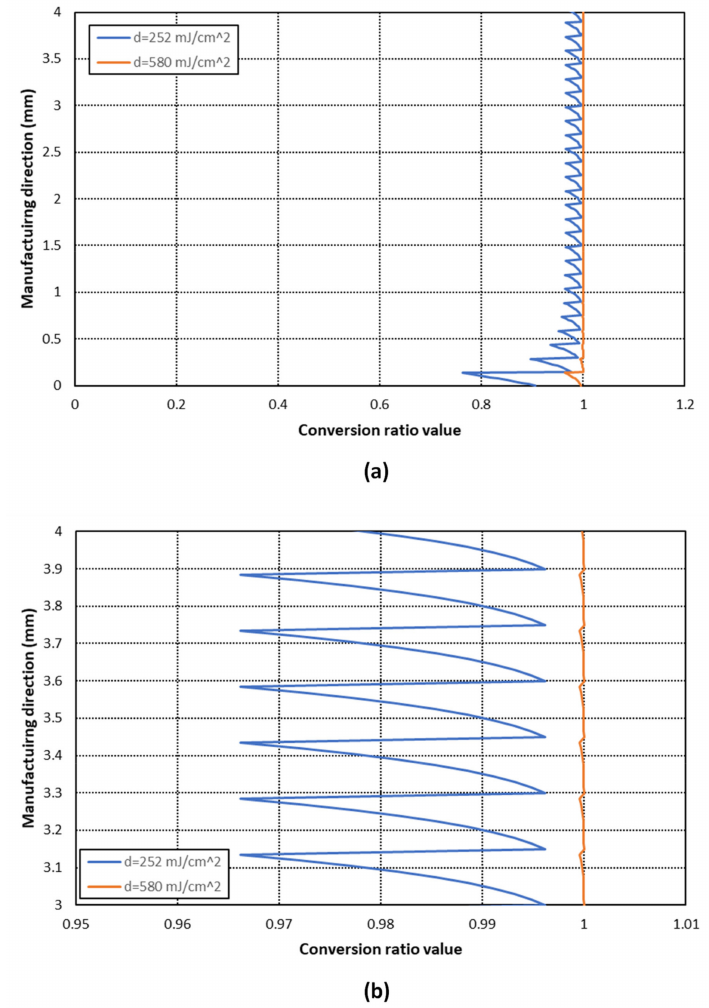
Figure 15. Comparison of conversion ratio distribution along the manufacturing direction for the photocurable material with a 10% SL and a layer thickness of 150 µ m according to the energy exposure dose. ( a ) It can be observed that a large difference is found in the last printed layers ( b ) Detail of conversion ratio values excluding the last printed